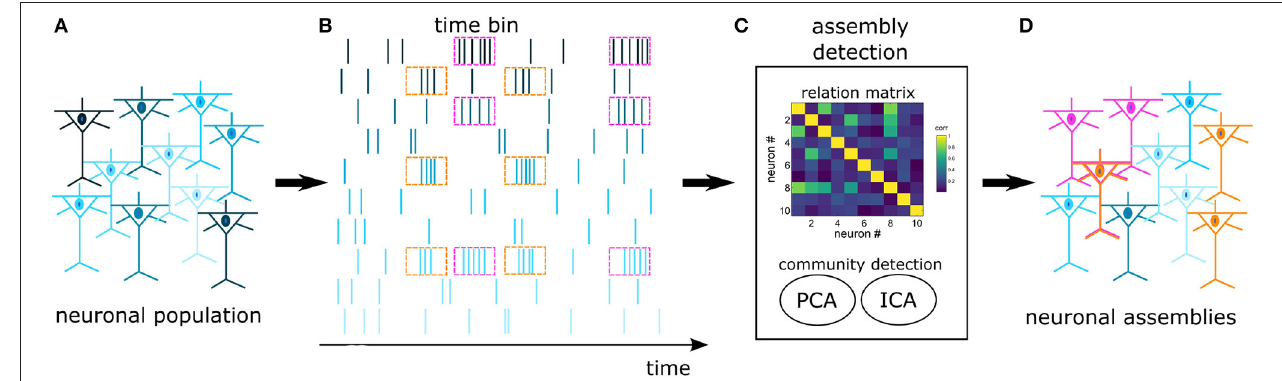
ICA community detection algorithm. The +